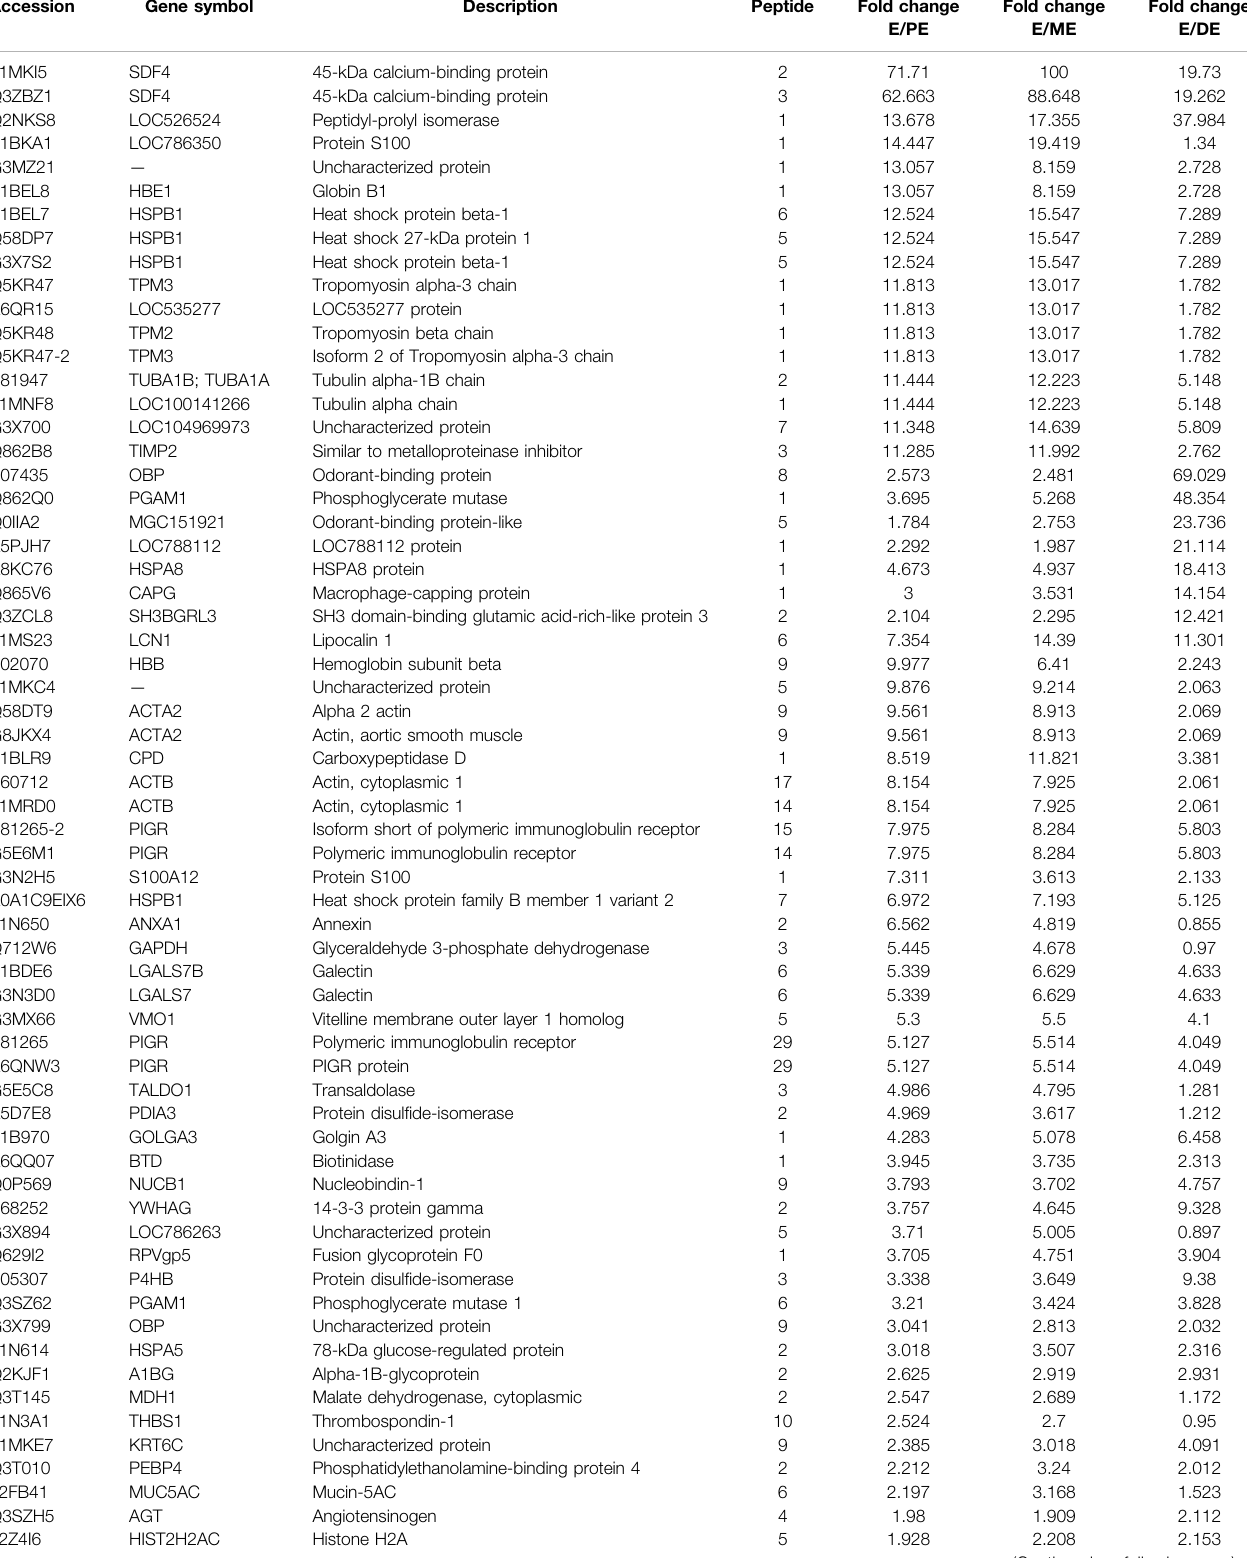
TABLE 4 | List of upregulated proteins during estrus (E) vs. proestrus (PE), metestrus (ME), and diestrus (DE) stages using TMT-LC-MS/MS analysis. Accession Gene symbol Description Peptide Fold change